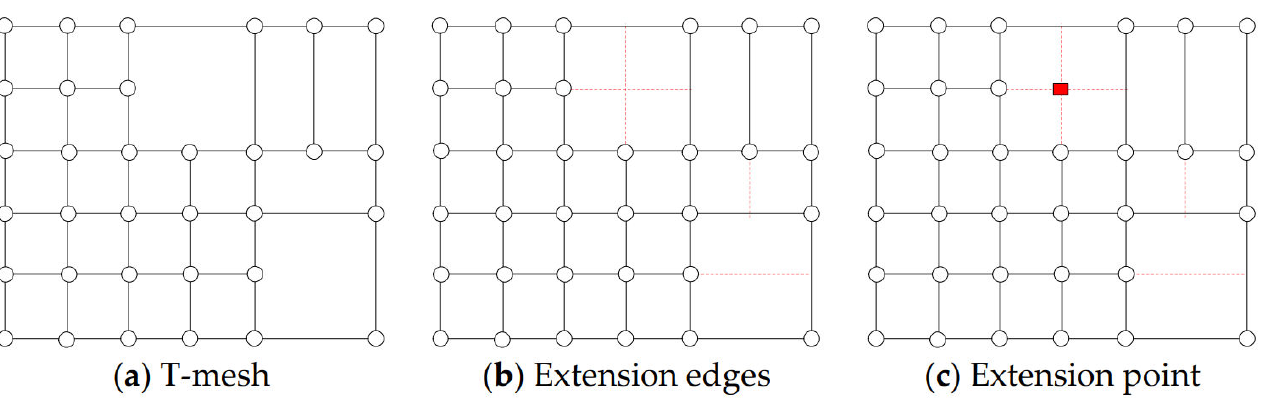
Figure 2. Extension edges of a T-mesh. ( a ) T-mesh; ( b ) extension edges: the red dashed line segments. If a horizontal extension edge intersects a vertical extension edge at point is called an extension point (see Figure 3). It can be inferred that i 0 (cid:54) = j 0 for any extension point.